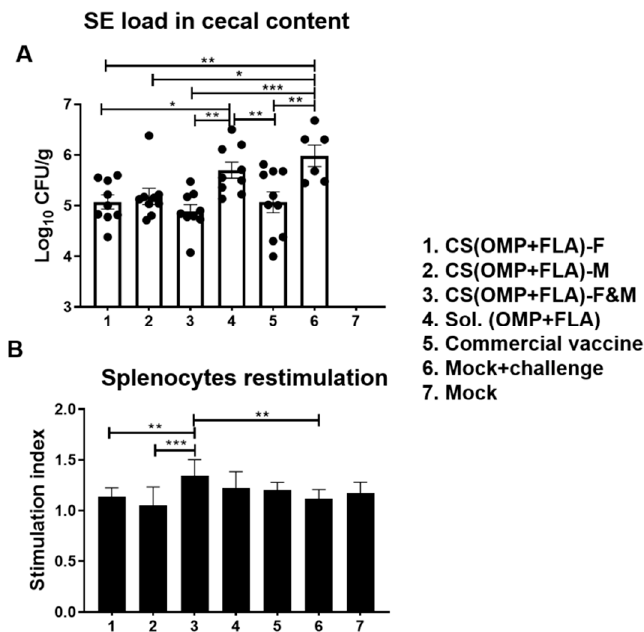
Figure 3. Salmonella Enteritidis load in the cecal content and antigen-specific lymphocyte proliferation response in splenocytes of vaccinated and challenged birds. ( A ) Salmonella CFU was enumerated in cecal content by plating on XLD agar plates and theindividual bird values were dot-plotted. ( B ) Splenocytes harvested on the day of necropsy were stimulated with 10 µg/mL SE antigens (OMP+FLA) for 48 h and lymphocyte stimulation index value was calculated by the mean OD of specific antigen (OMP+FLA) stimulated proliferation/mean OD of non-stimulated proliferation by a colorimetric assay. Data are presented as the mean ± SEM of 6 to 13 birds per group. Significant differences were determined by one-way ANOVA followed by Tukey post-hoc test between each of the groups. Only significant differences are labelled in the figures (* p < 0.05, ** p < 0.01, and *** p < 0.001).